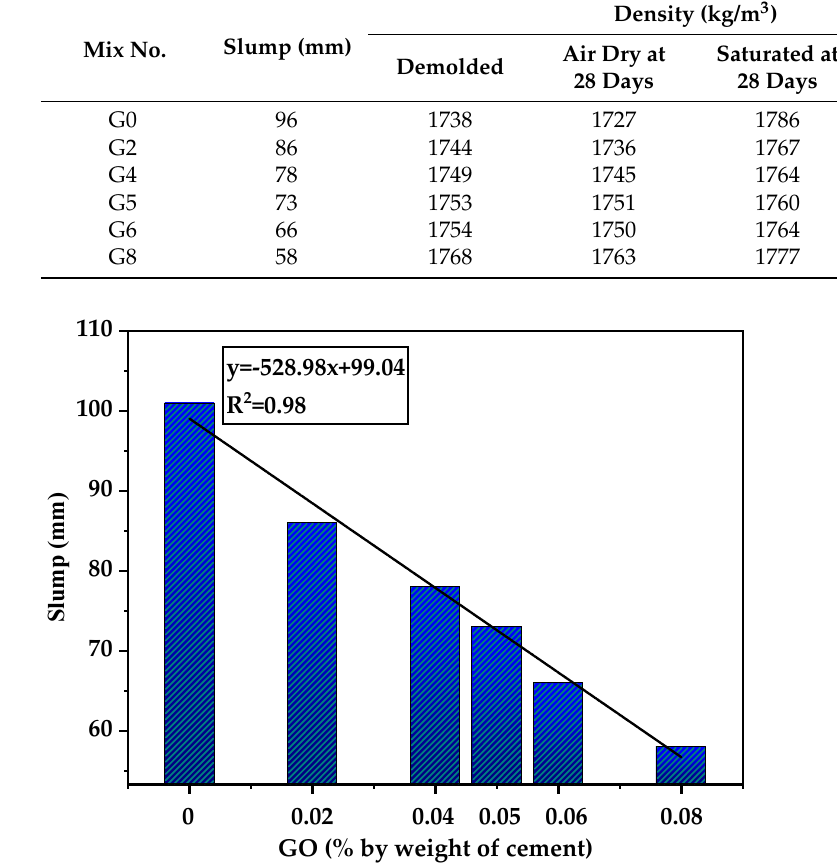
Figure 2. The relationship between slump and density with proportions of GO.